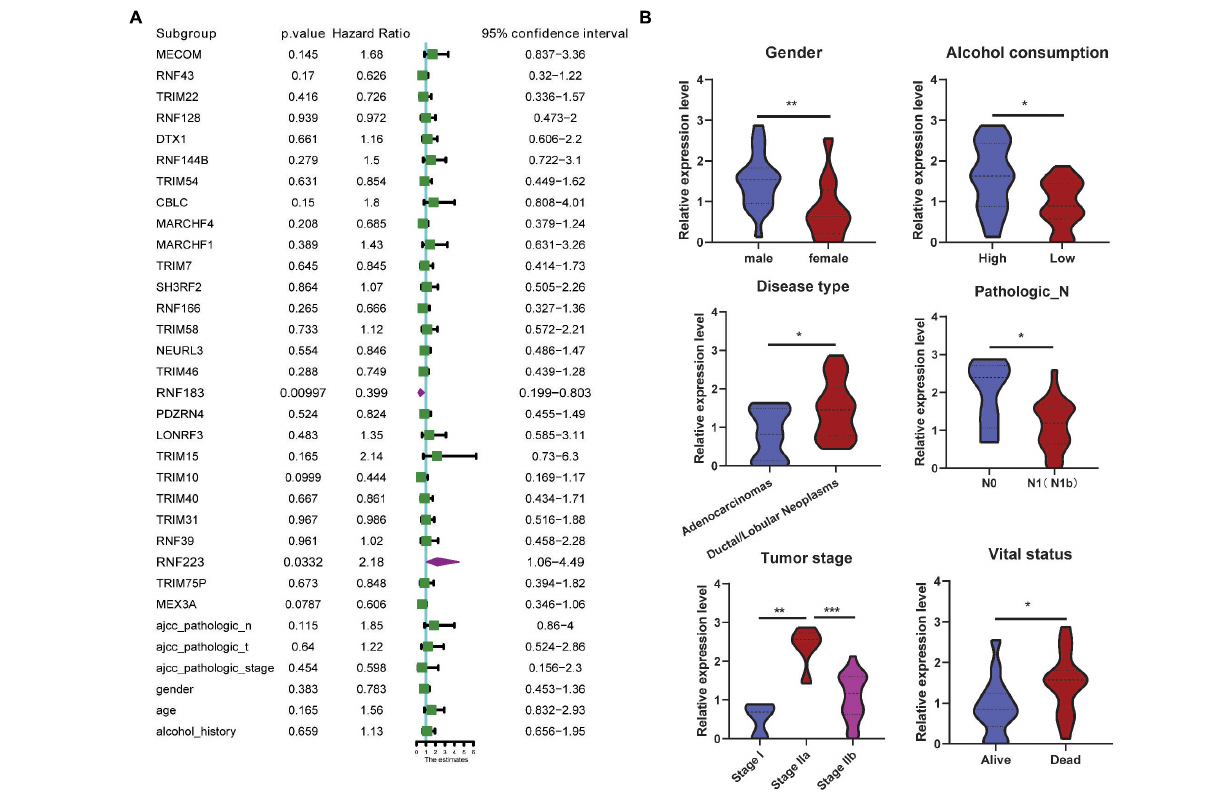
FIGURE 4 | RNF223 serves as an independent prognostic marker and correlates with clinical parameters. (A) Multivariate analysis of the 27 DEGs with prognostic significance in the TCGA PAAD dataset. (B) Expression analysis of RNF23 with clinical parameters; * p < 0.05, ** p < 0.01, *** p <